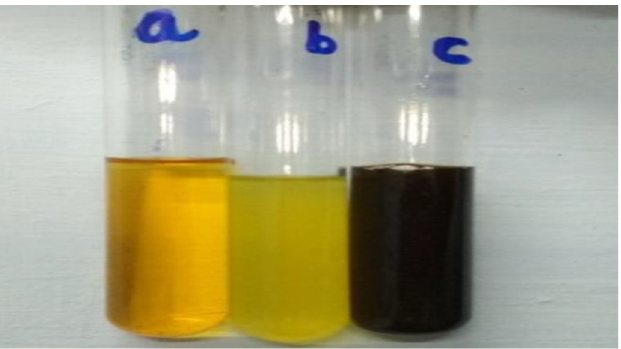
Figure 2. Synthesis of IONPs using Azadirachta indica (a—ferric chloride aqueous solution; b—neem leaf extract; c—synthesized IONPs).